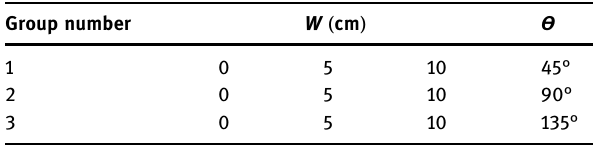
Table 2: The parameters of test